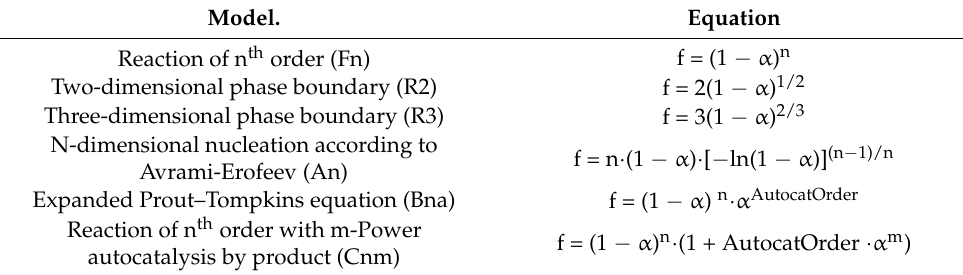
Table 2. Model methods for calculating kinetic parameters. Model. Equation Reaction of n th order (Fn) f = (1 − α ) n Two-dimensional phase boundary (R2) f = 2(1 − α ) 1/2 Three-dimensional phase boundary (R3) f = 3(1 − α ) 2/3 N-dimensional nucleation according to Avrami-Erofeev (An) Expanded Prout–Tompkins equation (Bna) Reaction of n th order with m-Power autocatalysis by product